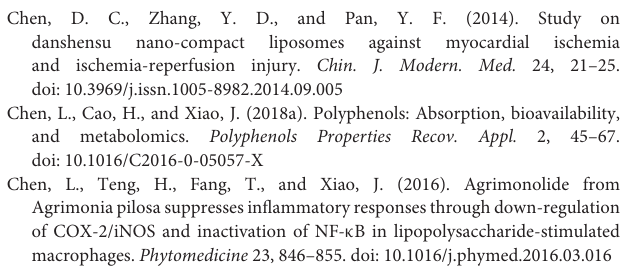
[ Table 5E : culture environment (culture media/sera, pH/CO 2 and temperature)]; (6) the items of random allocation and blinding are essential to RoB (O’Connor et al., 2011; Zhang K. J. et al., 2017) ( Table 5F : random allocation to treatment or control; 5G: blinded induction of model; 5H: blinded